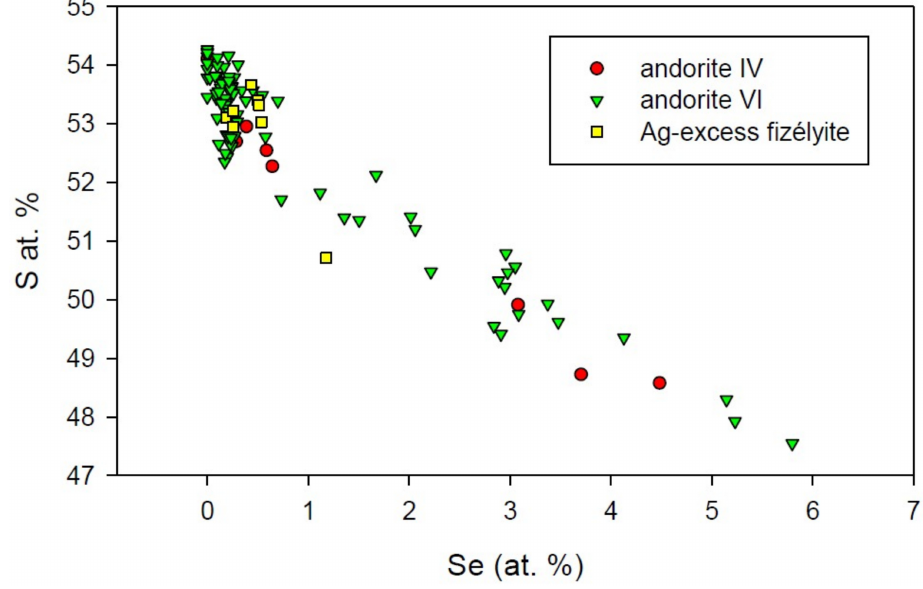
Figure 24. Graph of Se vs. S contents (at. %) for members of the andorite branch from the Kremnica